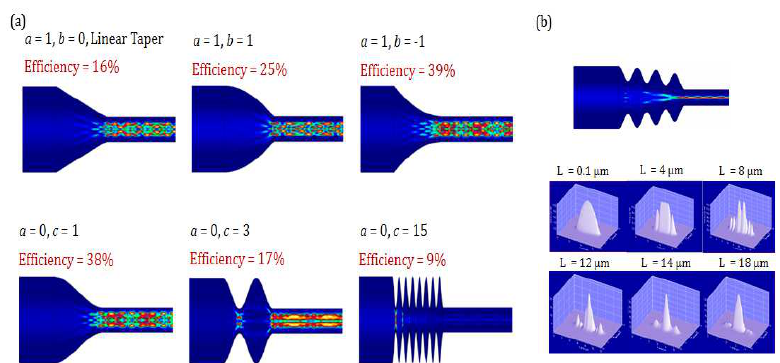
Figure 12. Optical intensity profiles of the compact taper at length = 14.5 µ m for ( a ) various a , b , c values and ( b ) Optimized Value (95% efficiency) and 3-D Mode Profile along the length (L) of a Compact Taper on SOI Platform.